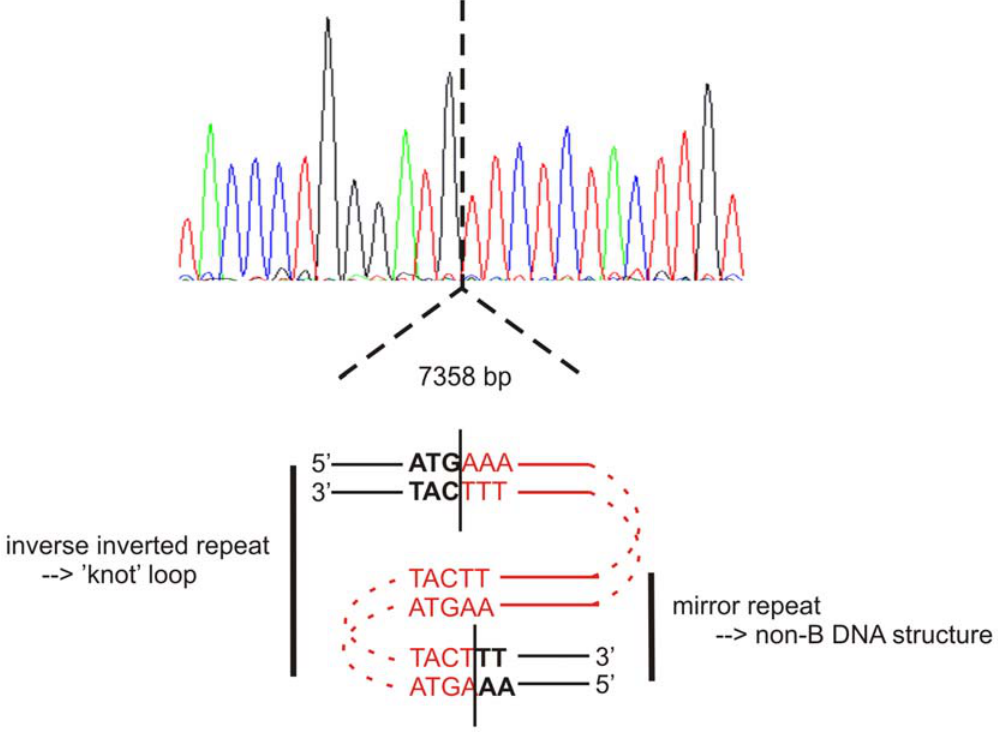
Figure 3. Characterization of 7.4 kb deletion. Top: Sequence electropherogram of the junction fragment of deletion D. The dotted vertical line indicates the position of the junction. Bottom: Schematic representation of the proposed mechanism underlying the 7.4 kb deletion. The deleted fragment is delineated by the vertical lines and represented in red. The retained basepairs are formatted in bold. It is hypothesized that a double- stranded break (DSB) at the telomeric side triggered the deletion, followed by a DSB repair mechanism guided by the formation of a knot loop between the reverse complement of the pentanucleotide motif at the centromeric end.